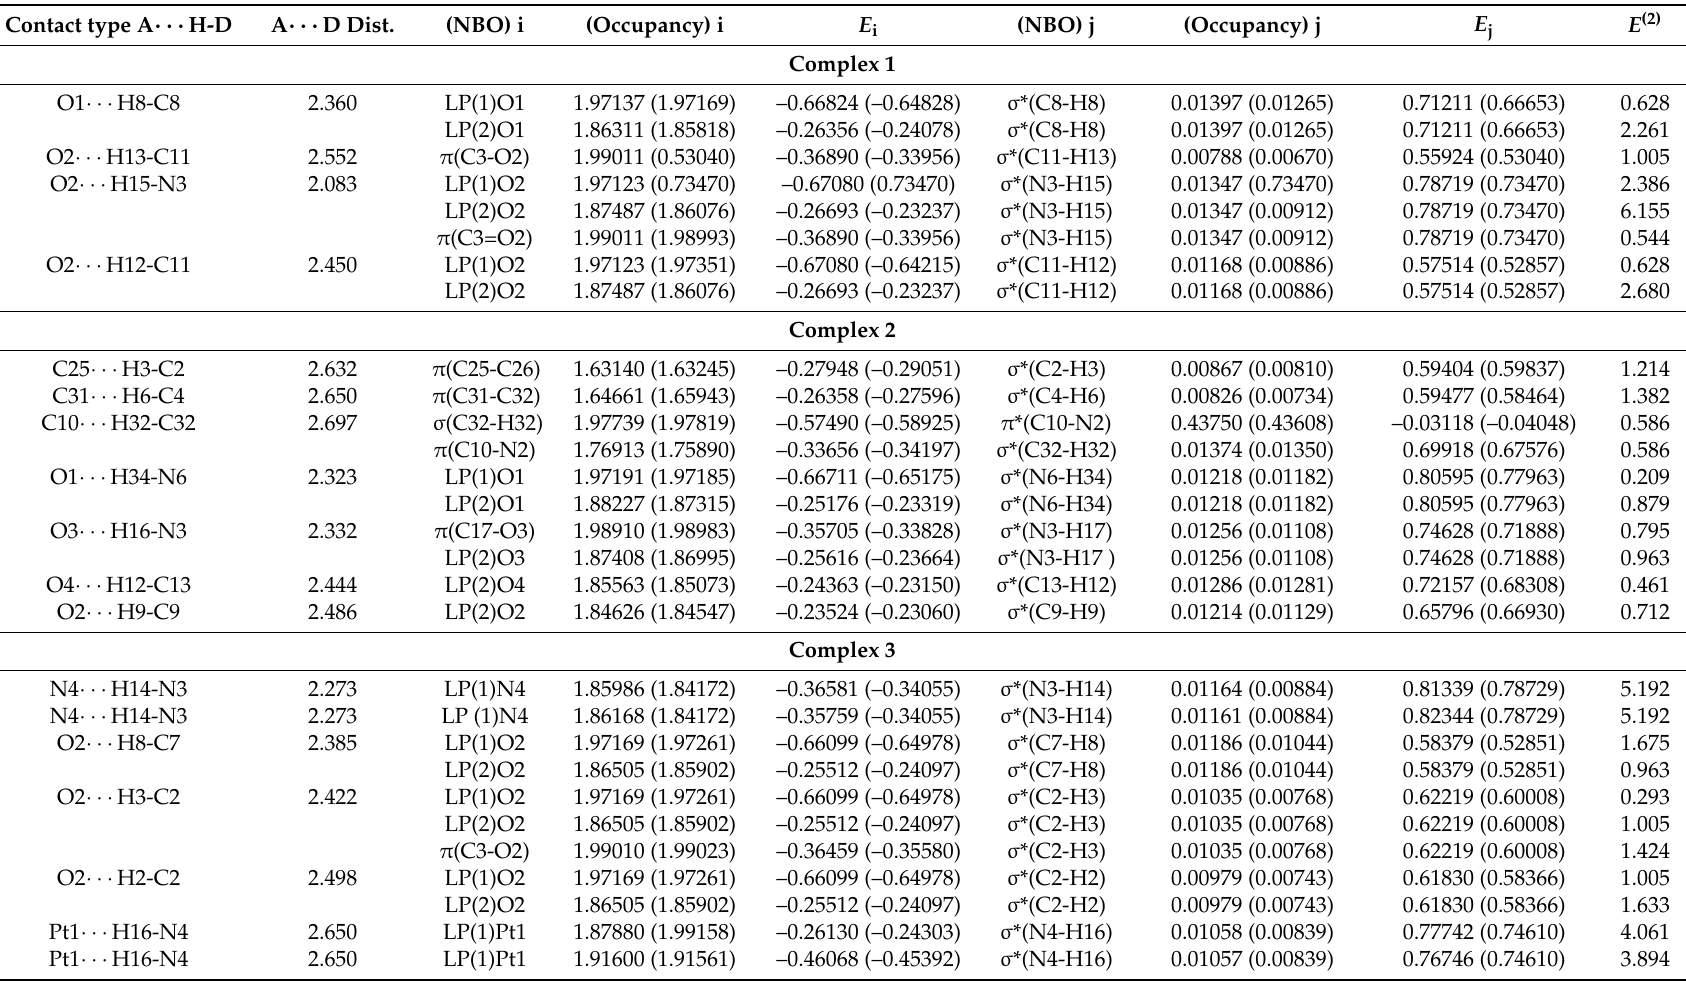
Table 4. Natural bond orbitals (NBOs) involved in the intermolecular interactions, their occupancies, energies (a.u.), and the second-order perturbation energies, E (2) ,